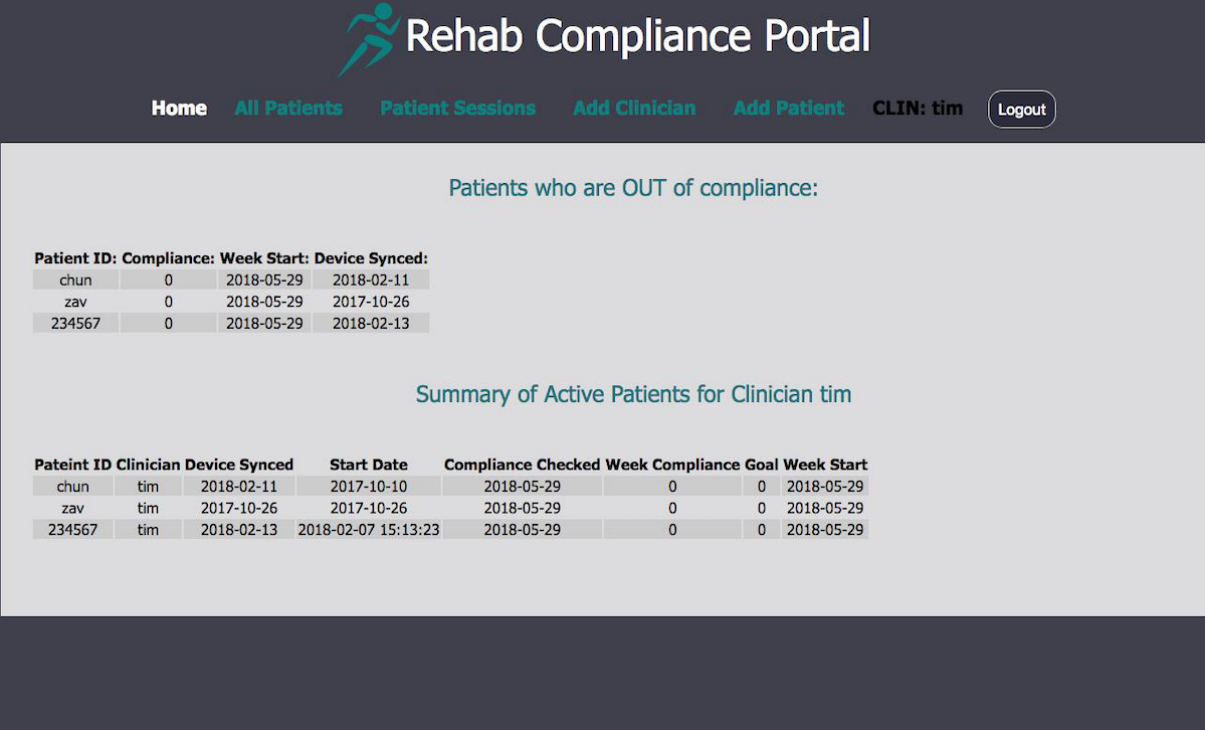
Figure 5. Sample screenshot of the clinician portal, which identifies patients who are nonadherent; provides summary information on the current patients; and offers functionality to view all patients, individual patient sessions, and to add clinicians (administrator only) and